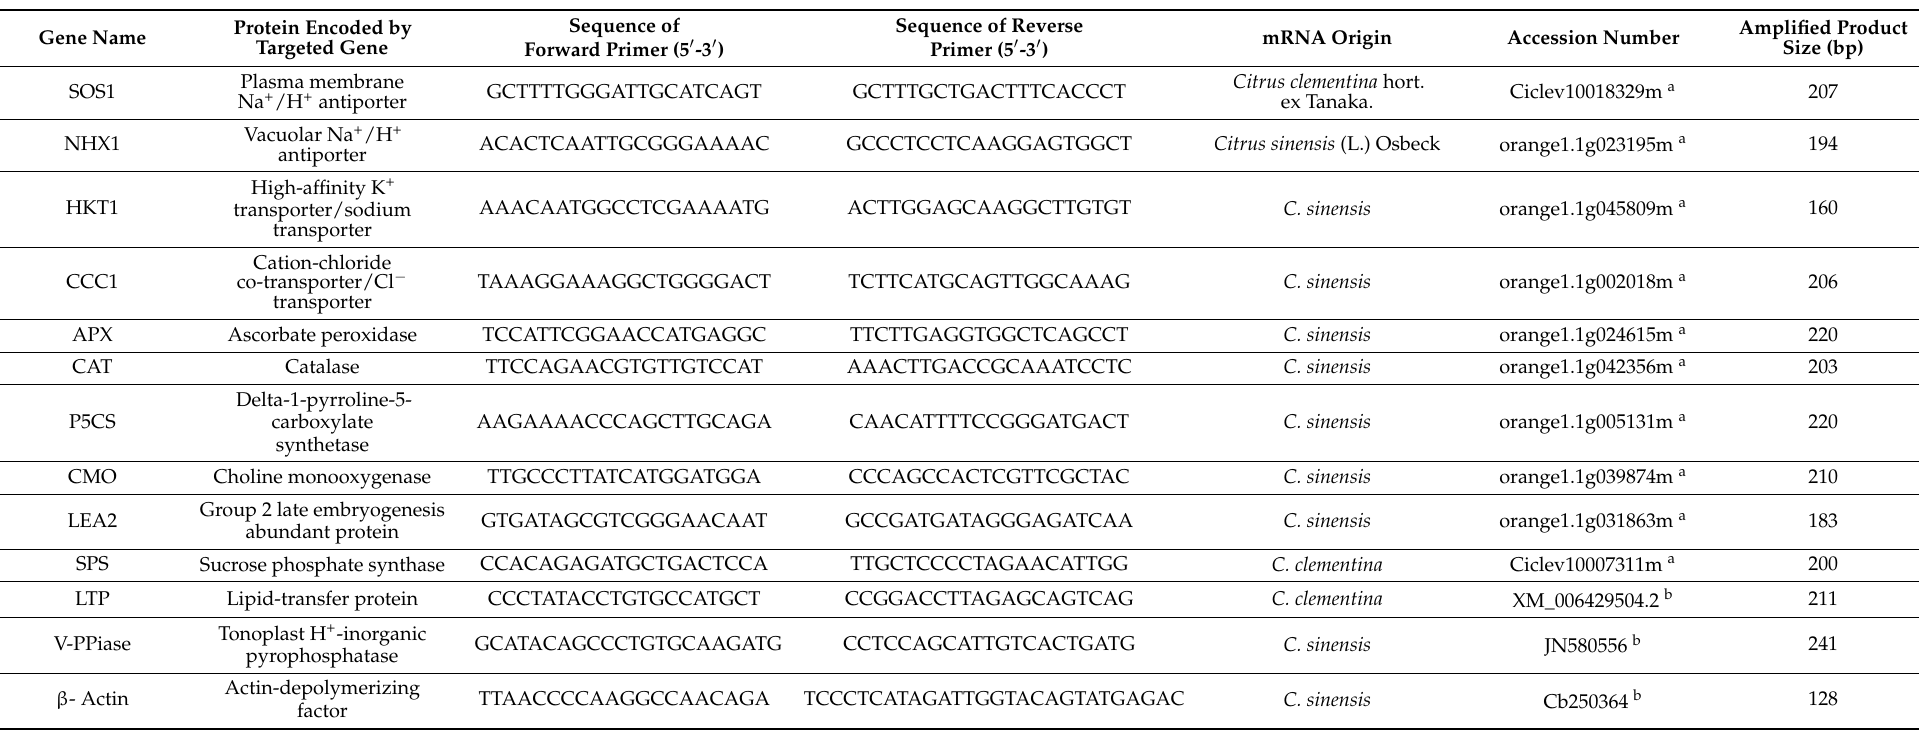
Table 1. List of primers used for quantitative real-time